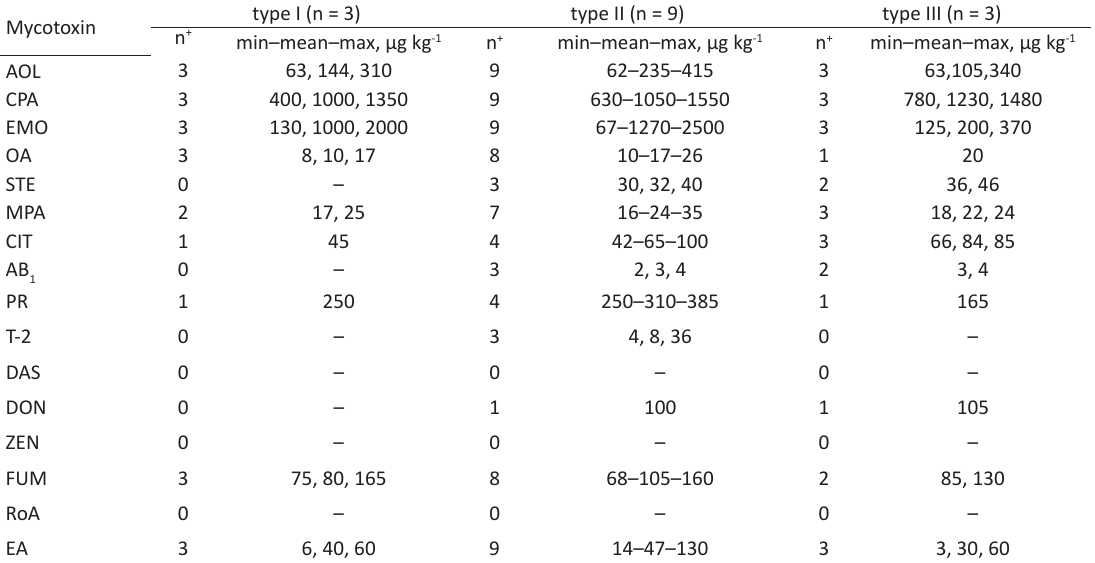
Table 3. Mycotoxins in different forage types before the second mowing type I (n = Mycotoxin